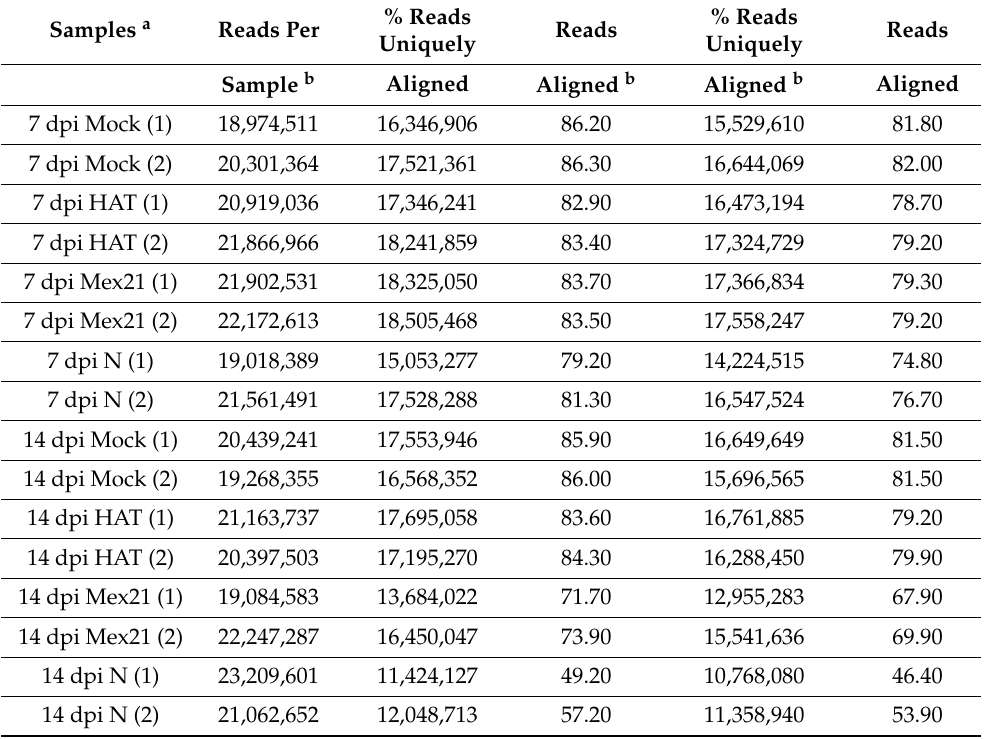
Table 1. Total reads from RNA-sequencing